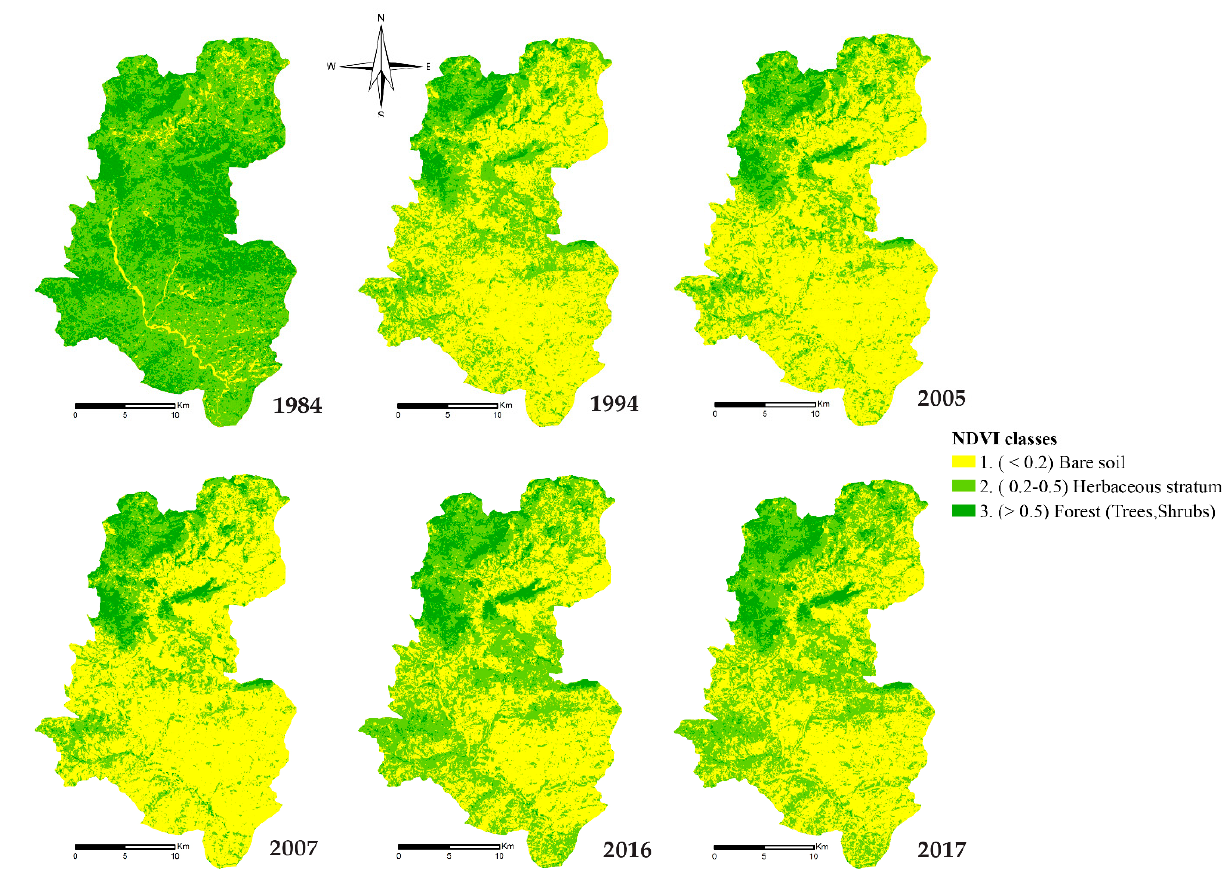
Figure 5. Monitoring of cover vegetation in the Oued Lahder watershed from 1984–2017.